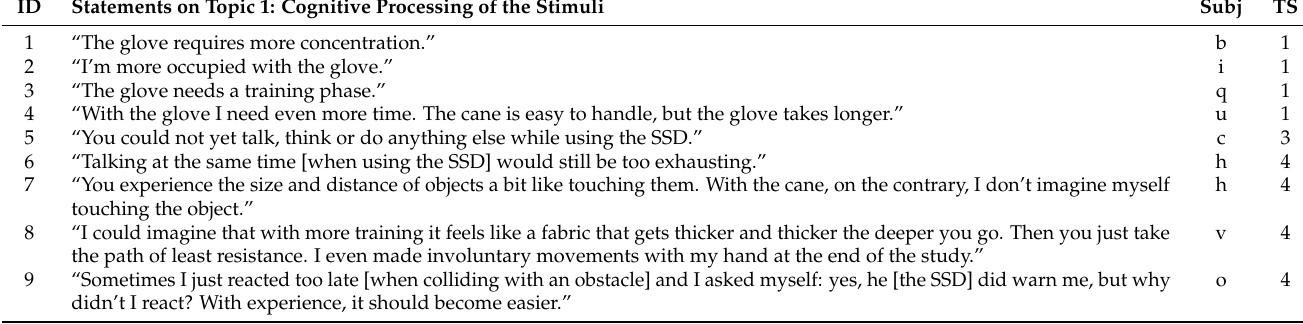
Table A3. Abbreviations used in this table: ID = statement identifier; Subj = subjects; TS = Trial